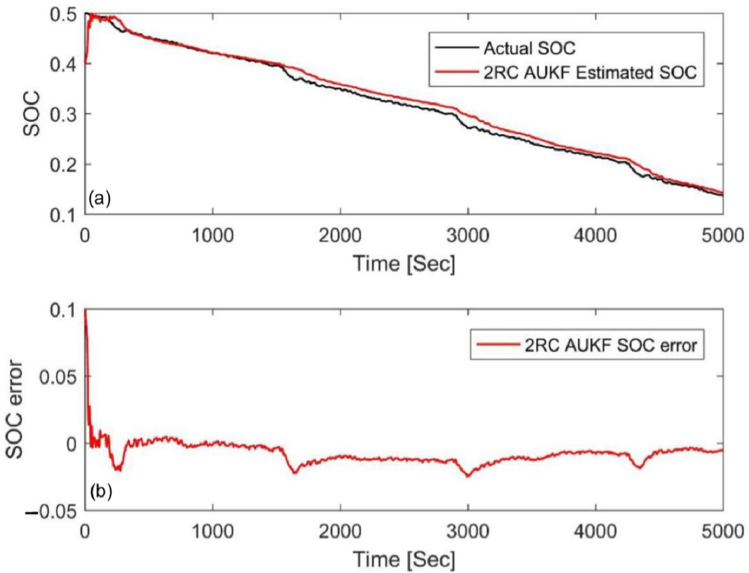
Figure 12. Estimation results at an initial SOC of 40% via the FUDS at 45 °C. ( a ) SOC estimation comparison curve; ( b ) SOC estimation error.